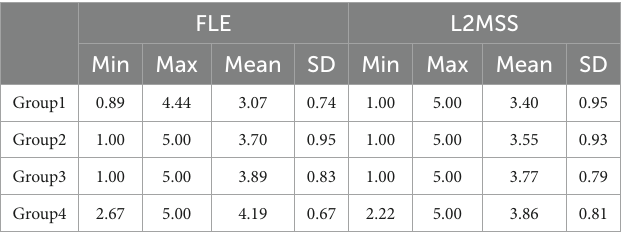
TABLE 2 Descriptive statistics of FLE and L2MSS at different proficiency levels.